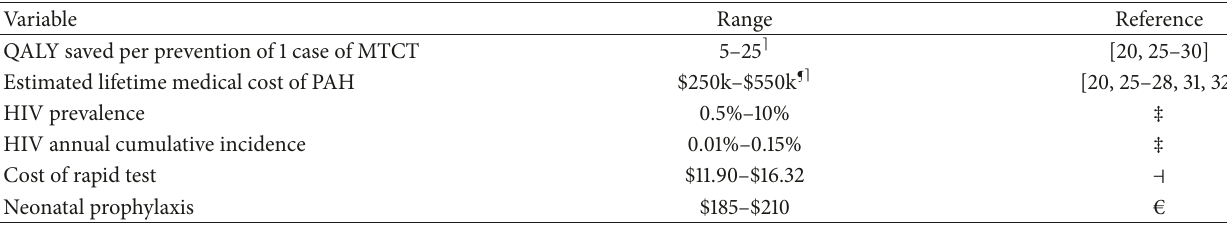
Table 3: Sensitivity analysis values and